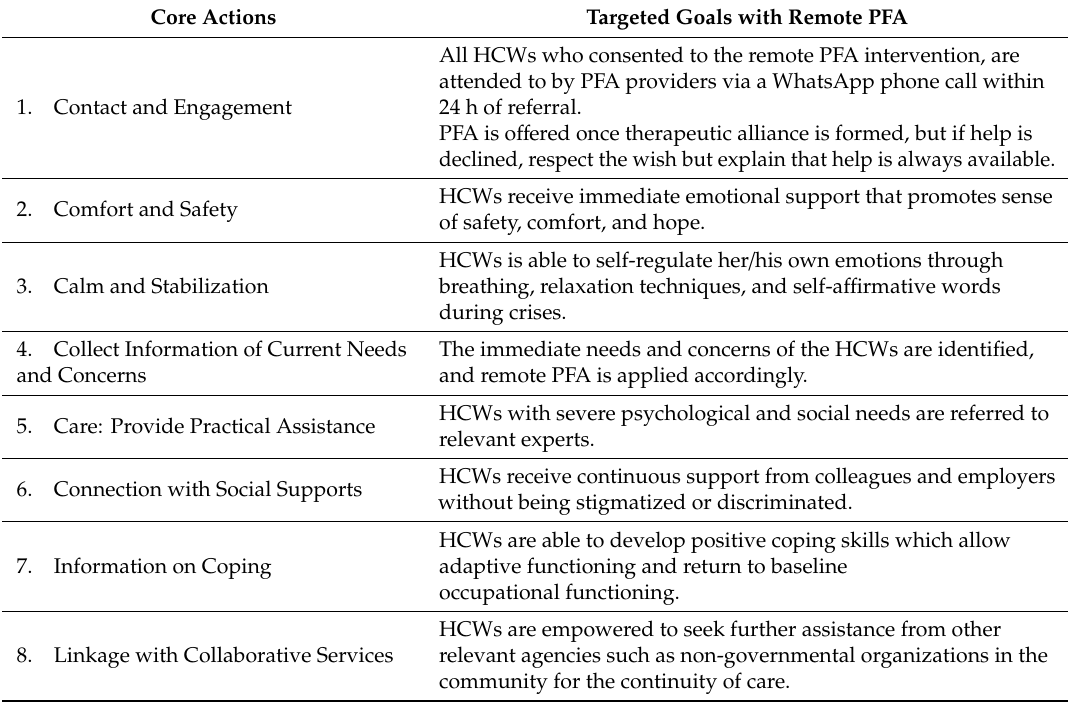
Table 1. An overview of the eight core actions based on the principle of “Look, Listen, Link” for healthcare workers during the COVID-19 pandemic (adapted from Forbes et al.,